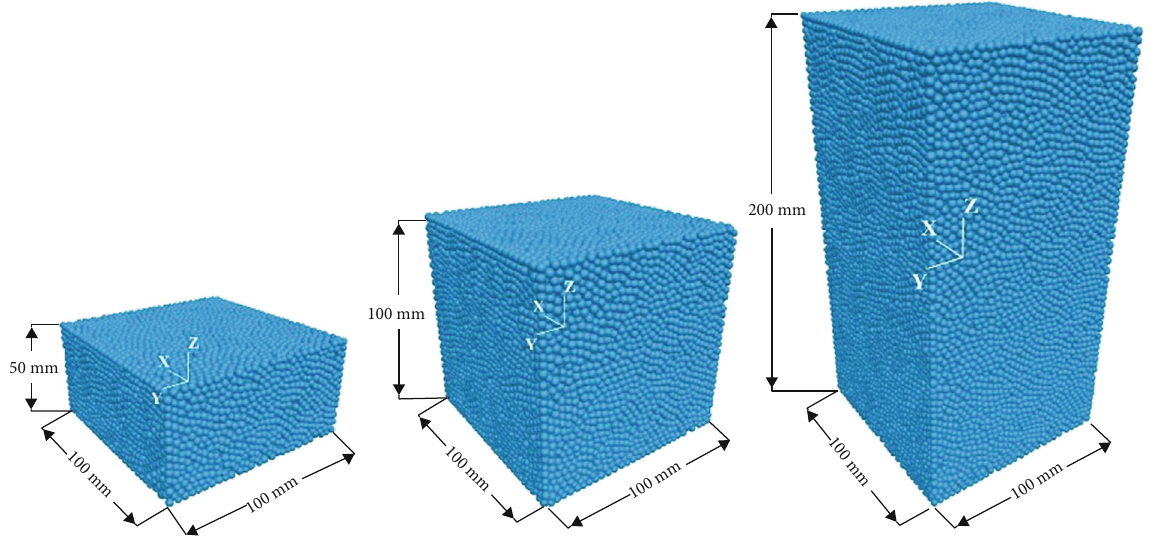
Figure 2: Numerical